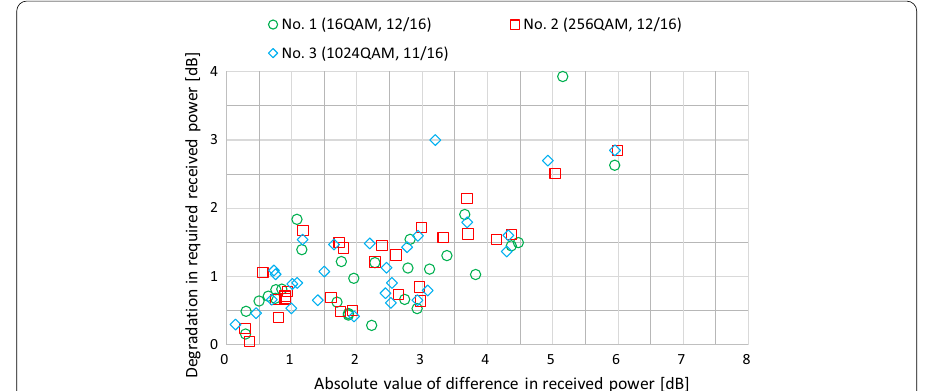
Fig. 19 Degradation in required received power from viewpoint of absolute value of difference in received power between horizontal and vertical polarization in field experiments